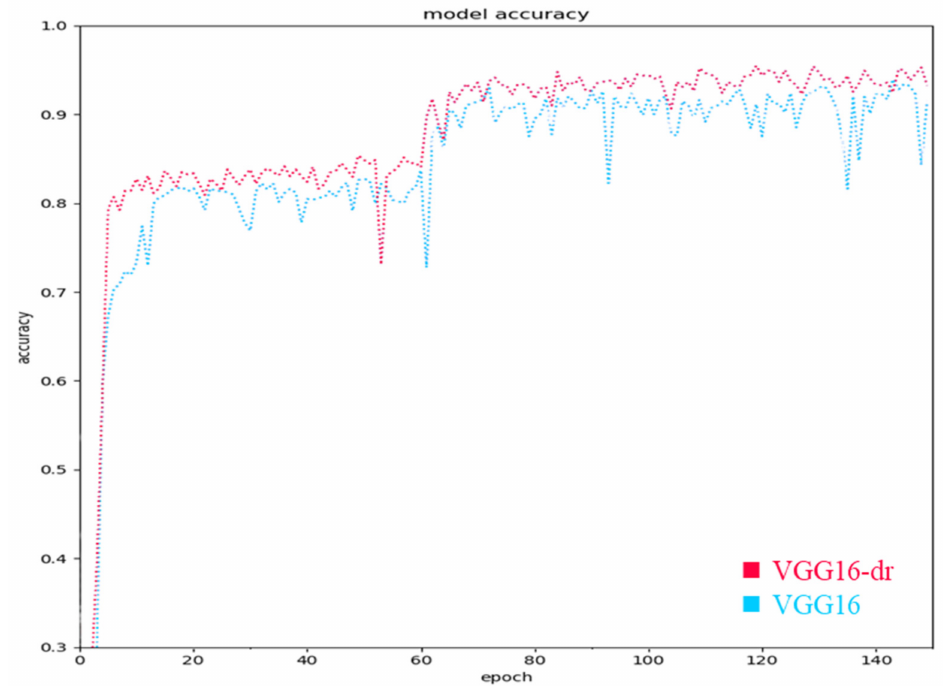
Figure 15. Comparison of testing accuracy in VGG16 and VGG16-dr